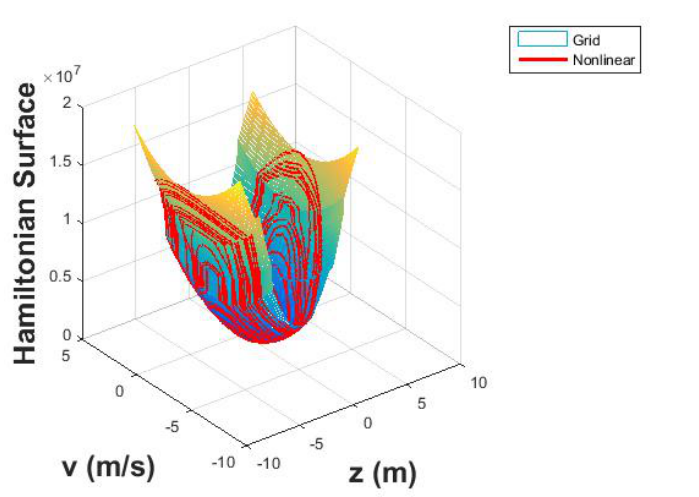
Figure 22. Hamiltonian surface for the nonlinear WEC in an irregular wave.